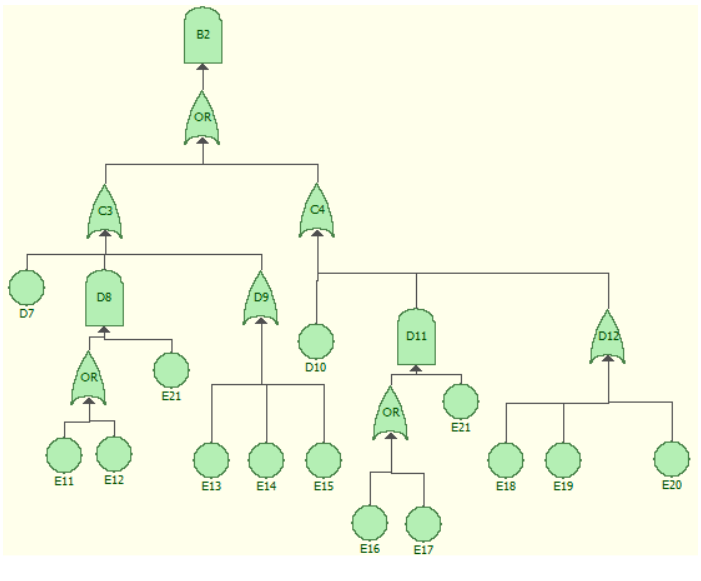
Figure 7. RTDS to ASN communication, third level fault tree